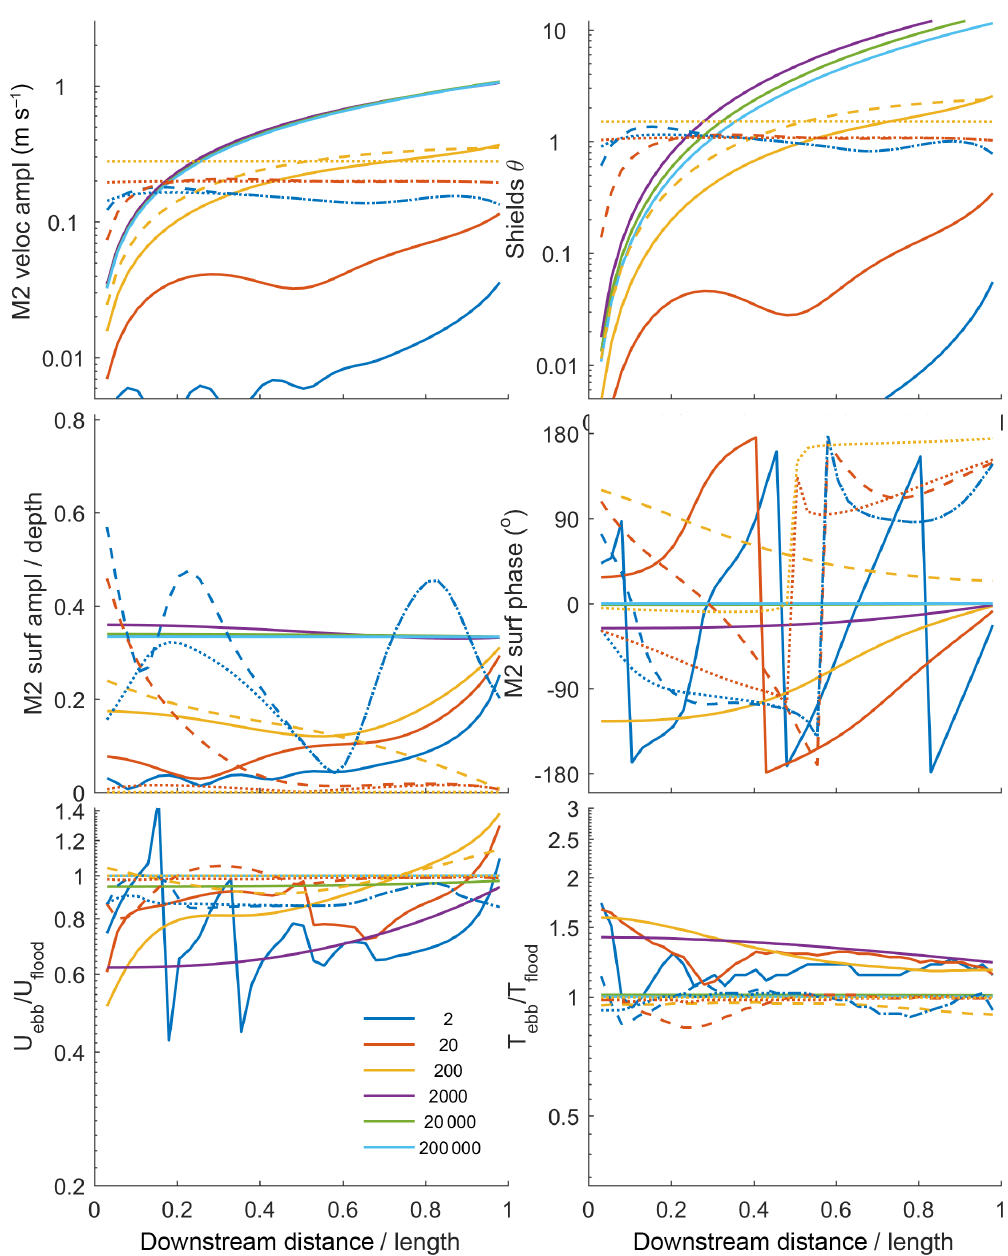
Figure 16. Scaling from Metronome to natural estuaries by the numerical model as n h = n T = n L for all settings, a constant a for the tilting set-up (dashed lines for tilt1 and dotted lines for tilt2) and a constant a/h for the Reynolds method (drawn lines). Legend indicates the length of the basin in metres, and the relative downstream distance is from 0:landward to